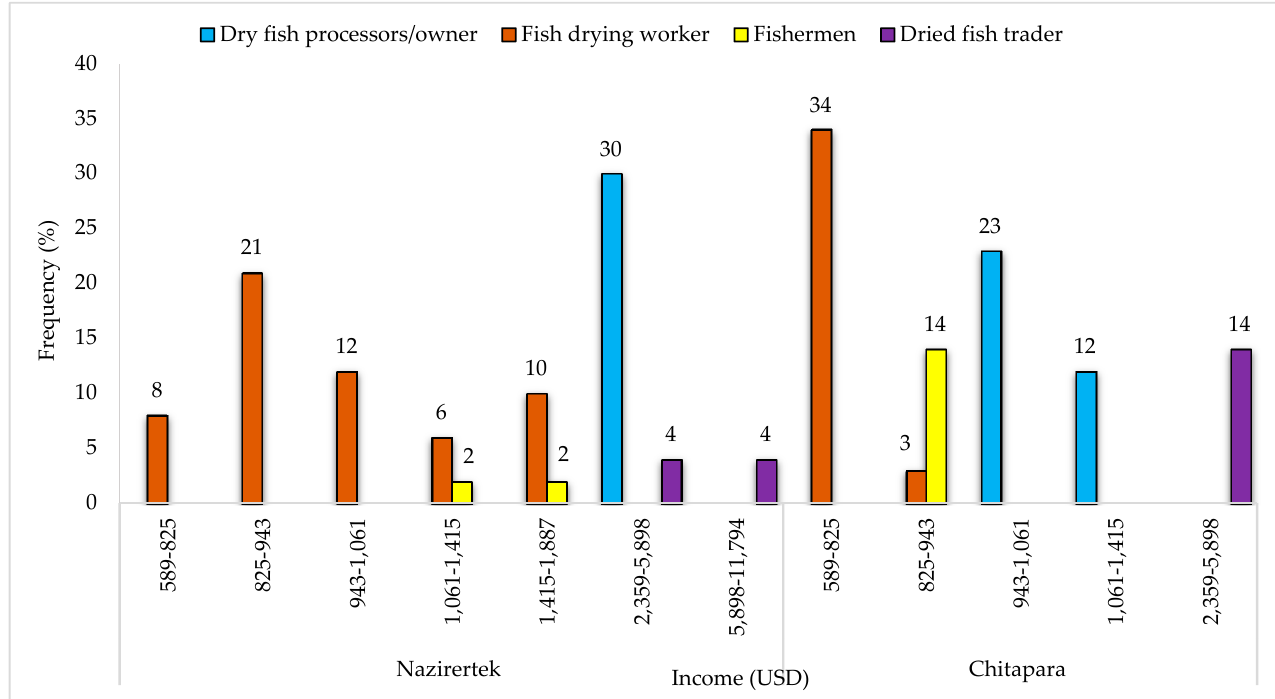
Figure 7. The annual income of the communities according to their occupations.